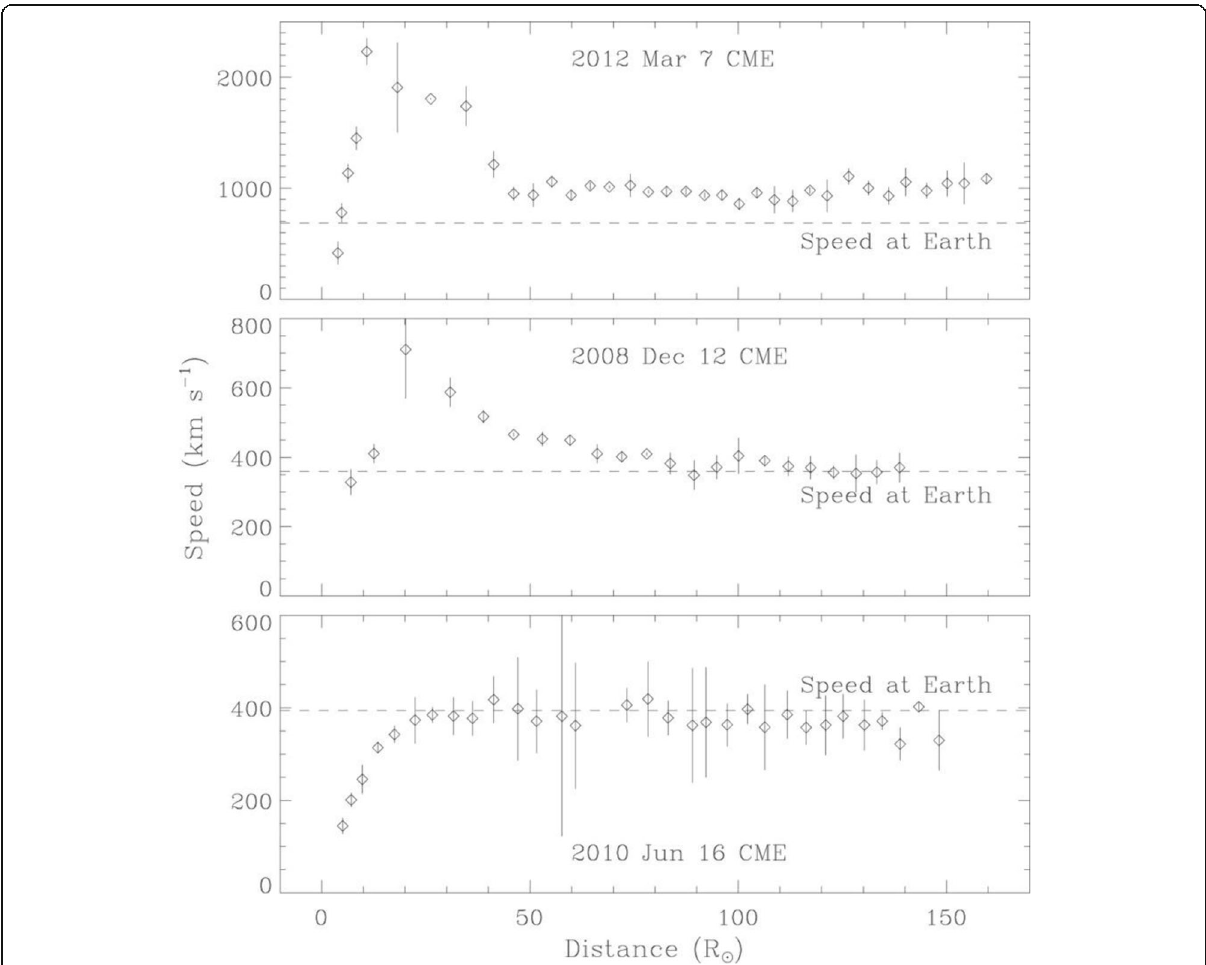
Fig. 4 Sun to Earth velocity profiles of a typical fast CME (upper), a typical intermediate-speed one (middle), and a typical slow one (lower). The horizontal dashed line indicates the observed speed at the Earth. Adopted from Liu et al.